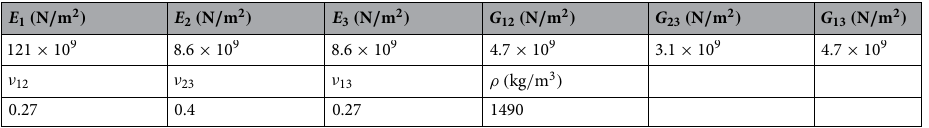
Table 1. Engineering constants of Epoxy Carbon UD (230 GPa) material used for individual laminas of a composite plate.